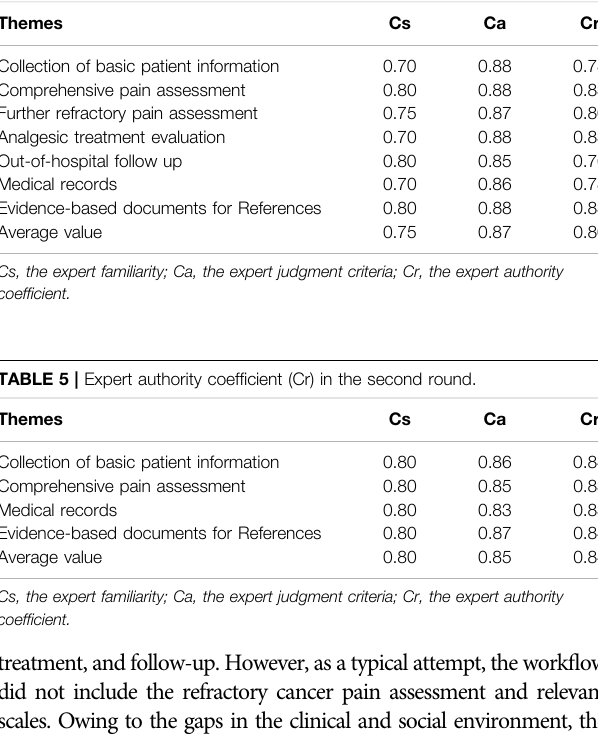
TABLE 6 | Coef fi cient of concordance (W) of experts in each